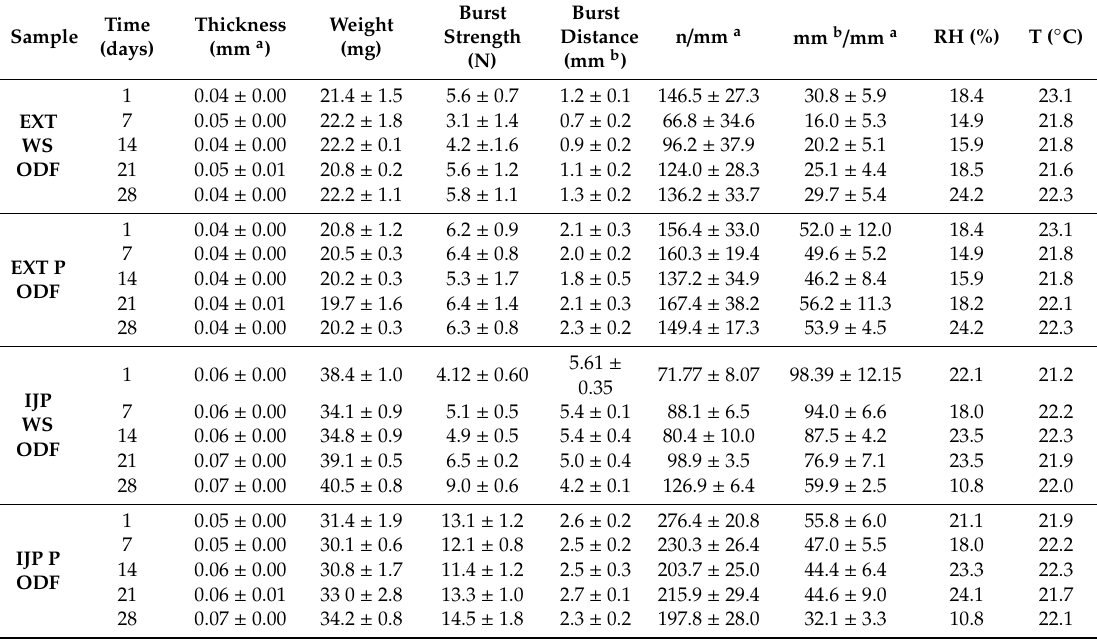
Table A2. Mechanical properties of the ODFs. Results are reported as average ± SD, n = 5, except for the humidity and temperature, which describes the conditions at the beginning of the first measurement.